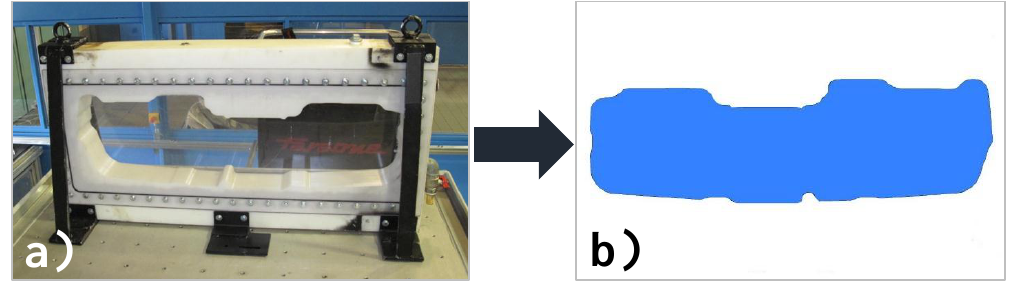
Figure 6. ( a ) Real fuel tank, ( b ) Extracted fluid volume.